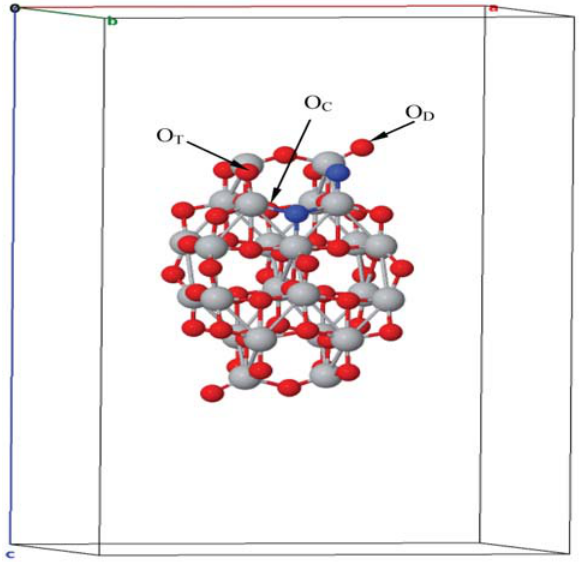
Figure 1. Optimized structure of the 72 atom N-doped TiO nanoparticle constructed from 3 × 2 × 1 unit cells; O gen; O : twofold coordinated oxygen; O T